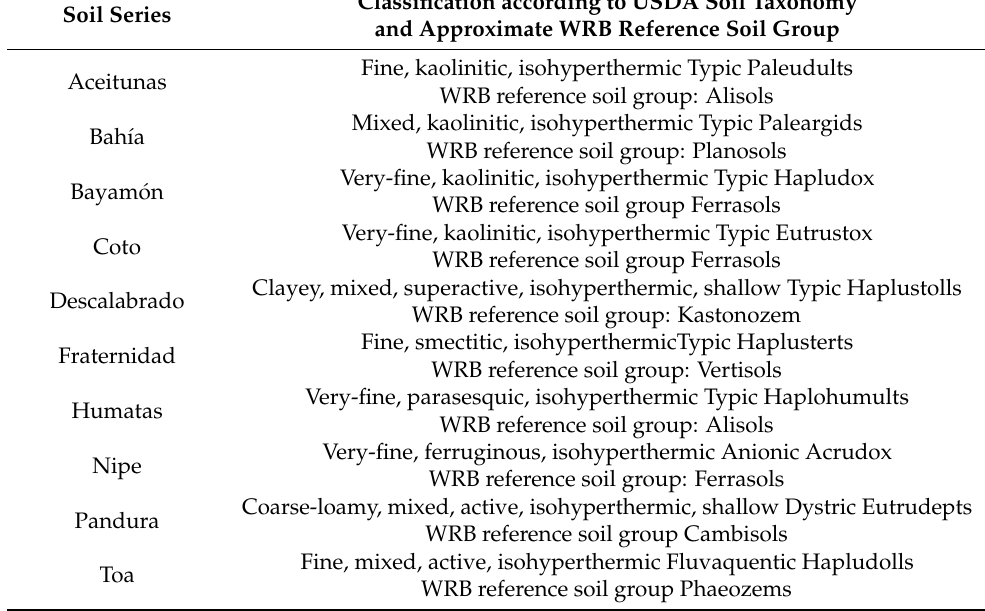
Table 2. Soil series included in the study.